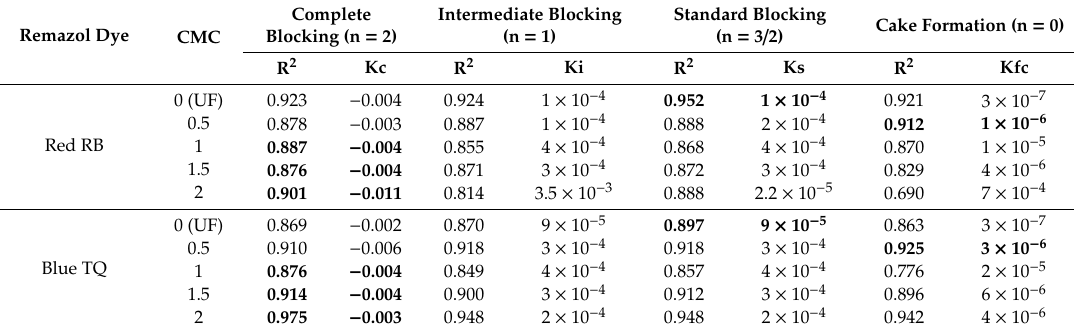
Figure 5. Fitting of experimental data to Hermia’s model for Remazol Red and Blue dyes at saponin concentrations of ( A ) No saponin (UF), ( B ) 0.5 × CMC, ( C ) 1 × CMC, ( D ) 1.5 × CMC, ( E ) 2 × CMC. Table 4. Mathematical model parameter of ultrafiltration and MEUF blocking phenomena on indigo sol dye removal.